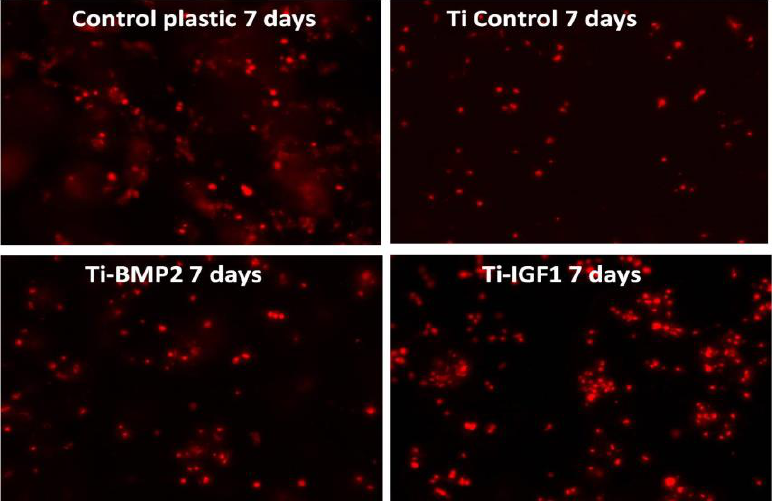
Figure 11. Cells with red fluorescence at the surface of the plastic wells and of the titanium discs with and without microcapsules containing the growth factors BMP2 and IGF1, after 7 days of cultivation (PKH staining).